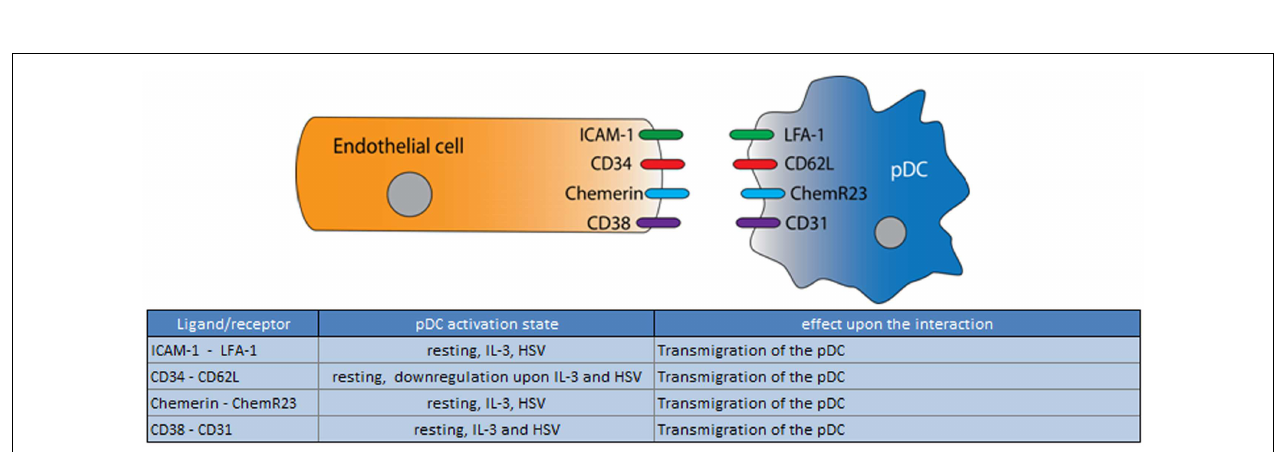
FIGURE 1 | Plasmacytoid dendritic cell have the capacity to interact with various immune cells through an array of surface molecules .The expressed surface molecules of each cell type are divided into confirmed and potential interactions.The “confirmed” molecules have been reported to have